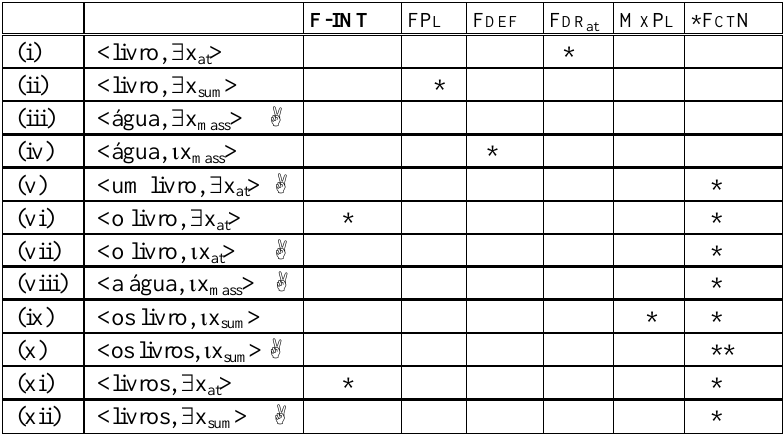
Tableau IV: English, European Portuguese, written Brazilian Portuguese Tableau IV spells out the ranking {FP L , MaxP L , F DEF , F DR *F UNCT N which BrP shares with European Portuguese, English, etc. A quick look at the optimal form-meaning pairs reveals that a grammar with this constraint ranking produces singular indefinites ( um livro ) (v), singular definites ( o livro ) (vii), definite mass nouns ( a água ) (viii), that have the same grammatical shape as singular definites, and plural definites which exemplify agreement on the noun ( os livros ) (x) in the DP